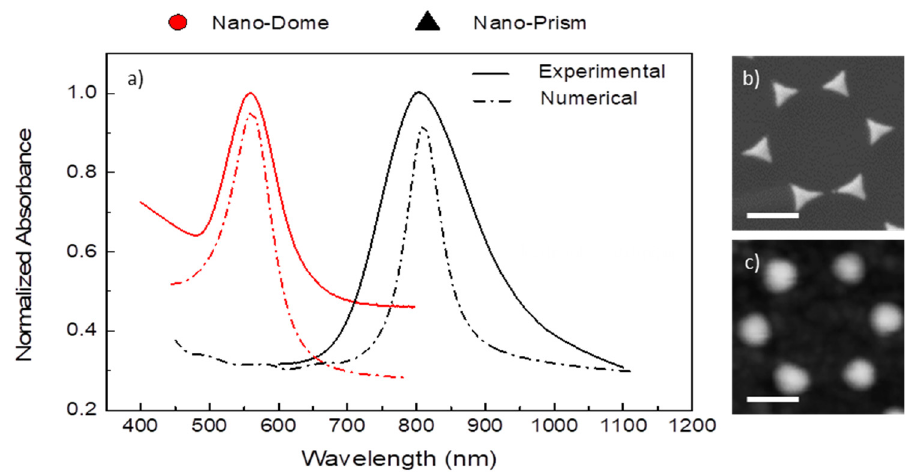
Figure 4. ( a ) Comparison of the calculated and the experimental normalized absorbance of a highly ordered array of gold nano-prisms and nano-domes; high-magnification AFM images of these structures are reported in Figure ( b ) and ( c ), respectively. The scale bar is 250 nm .